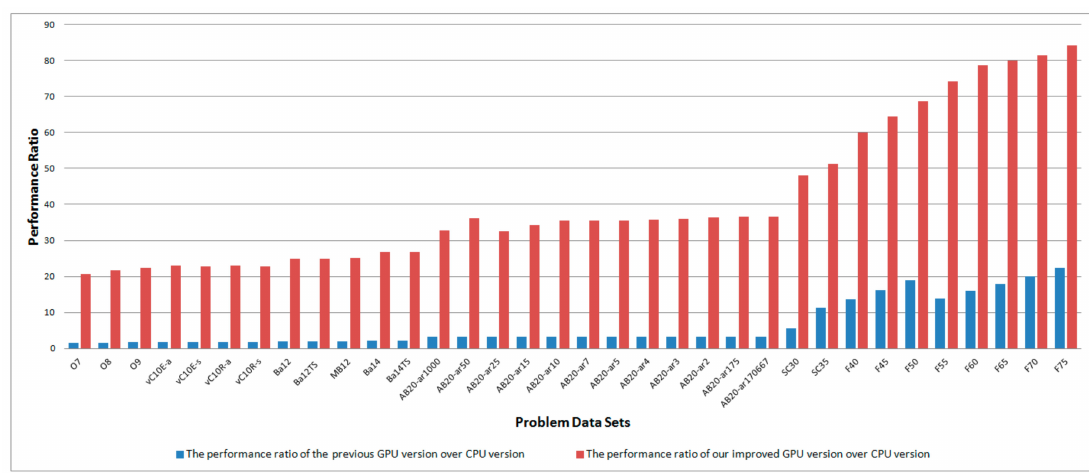
Figure 17. Comparisons of performance ratio between two GPU versions and CPU version,